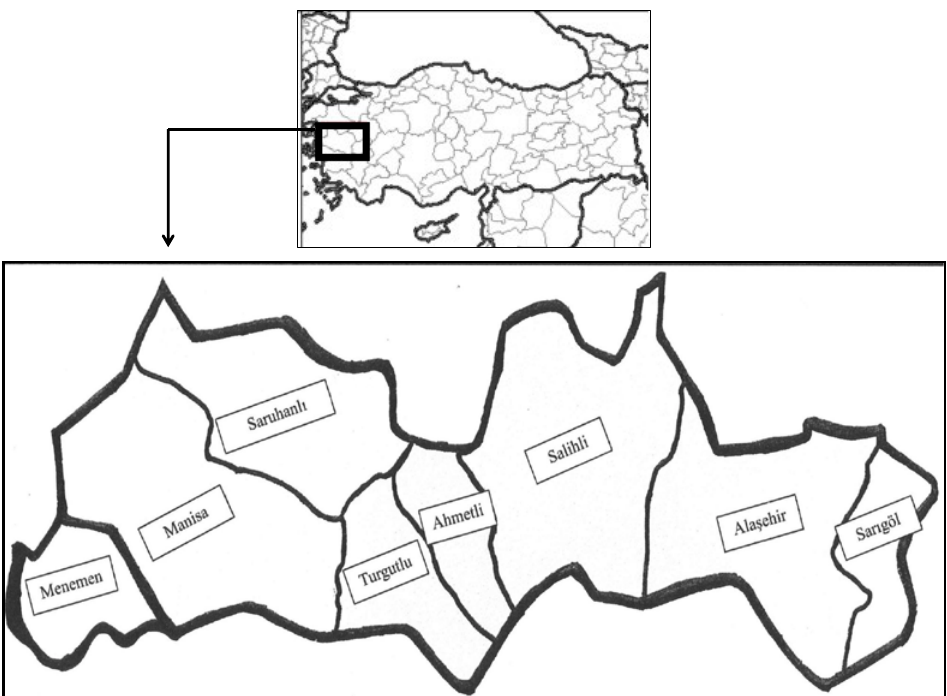
Figure 1. Map of Turkey showing the Sultana Seedless raisin-grape production region of the Aegean where the vineyards were